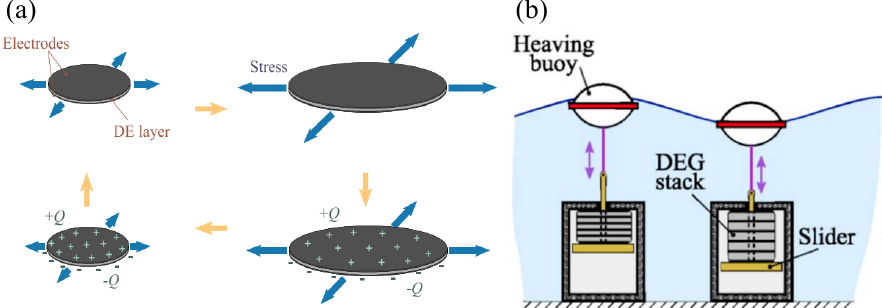
Figure 16. The working principle of a dielectric elastomer generator ( a ) and its application for a heaving point absorber ( b ), adapted from